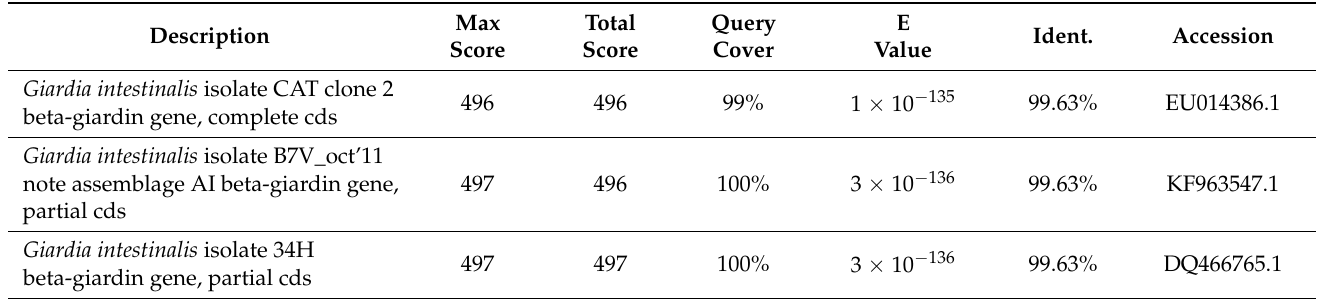
Table A1. BLAST results for the sequence obtained by PCR amplification of the G. duodenalis β -giardin gene (primer